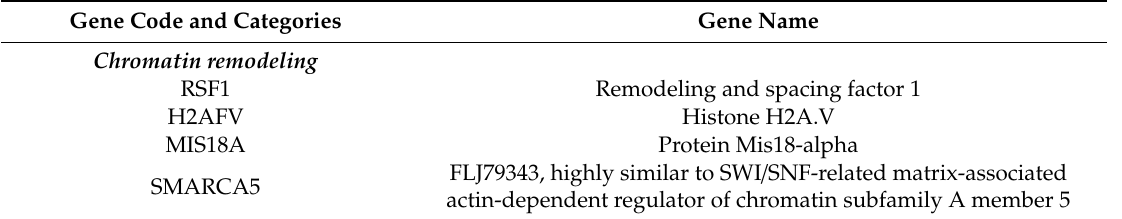
Table 4. Host proteins that interact with JCV Sm